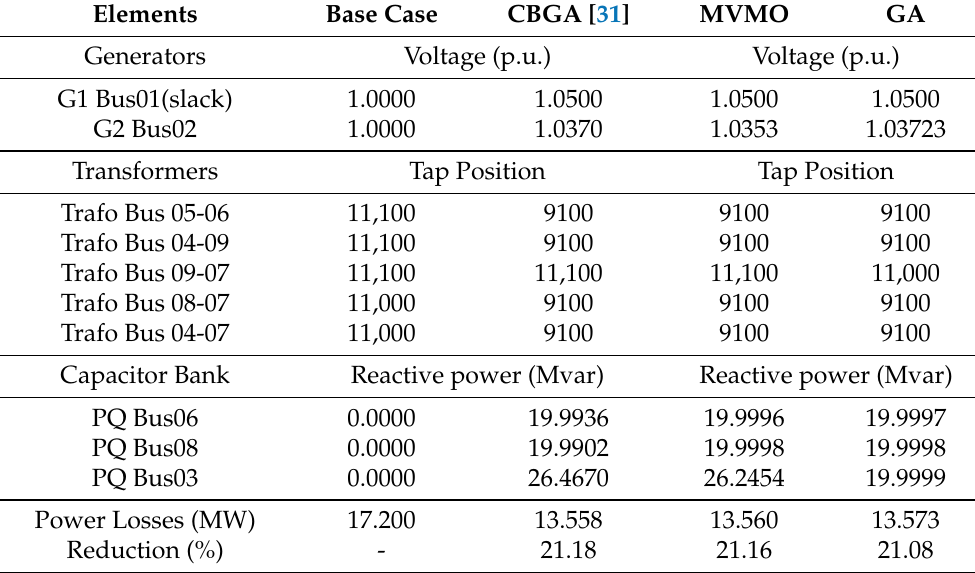
Table 10. Results for the IEEE 14-bus test system.